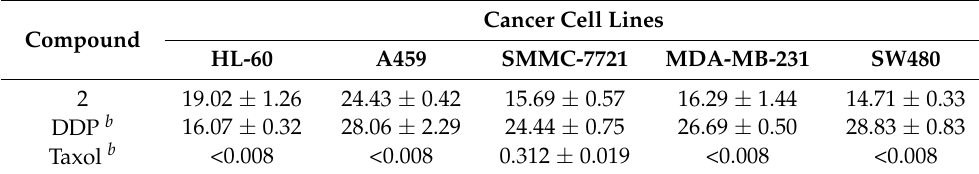
Figure 8. Cytotoxicity assay of compounds 1 – 3 against five human cancer cell lines (HL-60, A549, SMMC-7721, MCF-7, and SW480) at concentrations of 40 µ M. Results are expressed as mean ± SD ( n = 3). Table 4. Inhibitory effects of 2 on human cancer cell lines in IC 50 (μM) a .